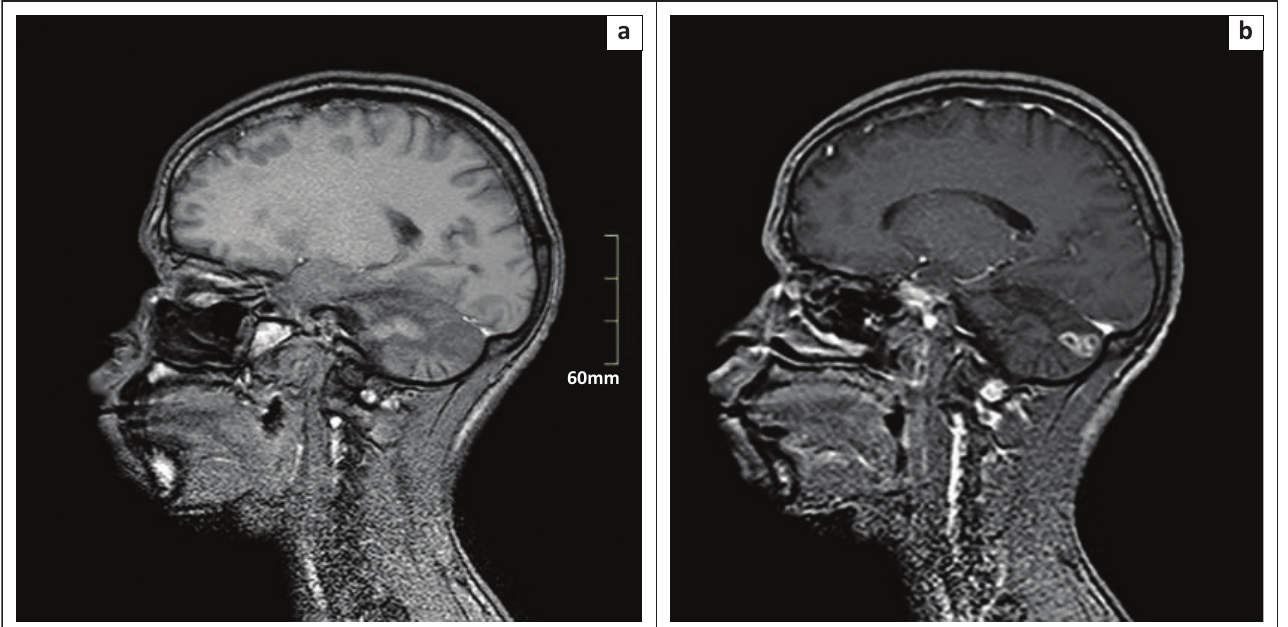
FIGURE 2: Sagittal pre-(a) and post-contrast (b) T1W images of the patient discussed in Case 2 at the level of the right cerebellar hemisphere demonstrating low signal intensity in the cerebellum with enhancement in the same region post-contrast administration.